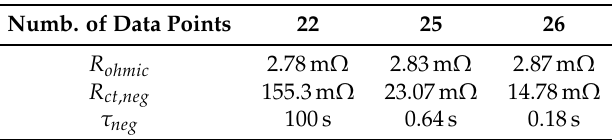
Table A2. The fitting results for R ohmic , R ct , neg , and τ neg are presented. These correspond to the number of fitted data points presented in Figure